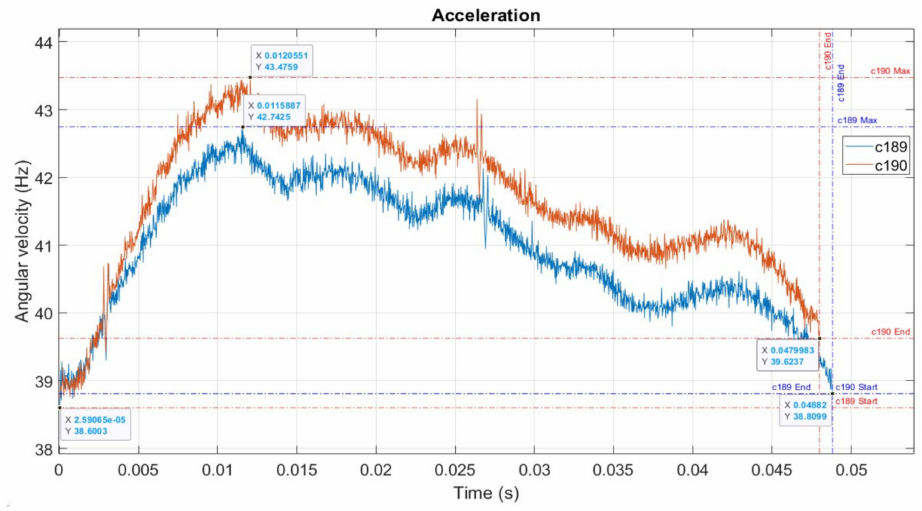
Figure 17. Cycles 189 and